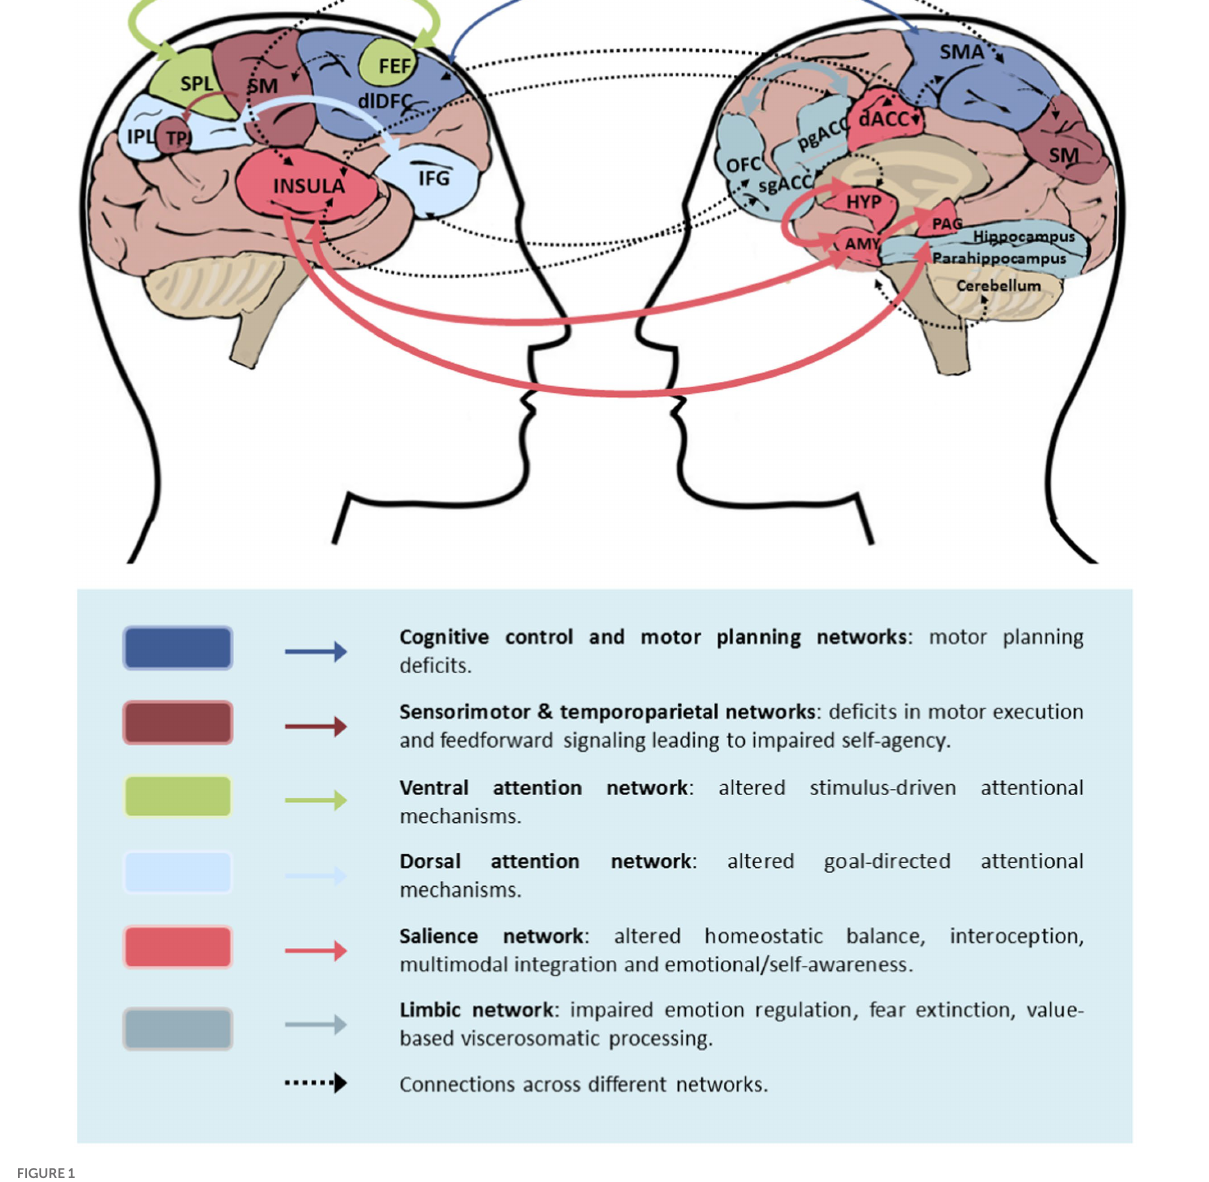
FIGURE 1 Neural correlates of FND involving impairment of awareness (FIAD) FIAD may include altered connectivity within and across brain circuit. This figure, adapted from Drane et al. (209), shows with thicker arrows the connections more likely to be involved in FIAD, amongst those implicated in FND in general. AMY, amygdala; SMA, supplementary motor area; dACC, dorsal anterior cingulate cortex; dlPFC, dorsolateral prefrontal cortex; HYP, hypothalamus; OFC, orbitofrontal cortex; pgACC, perigenual anterior cingulate cortex; sgACC, subgenual anterior cingulate cortex; SM, sensorimotor area; TPJ, temporoparietal